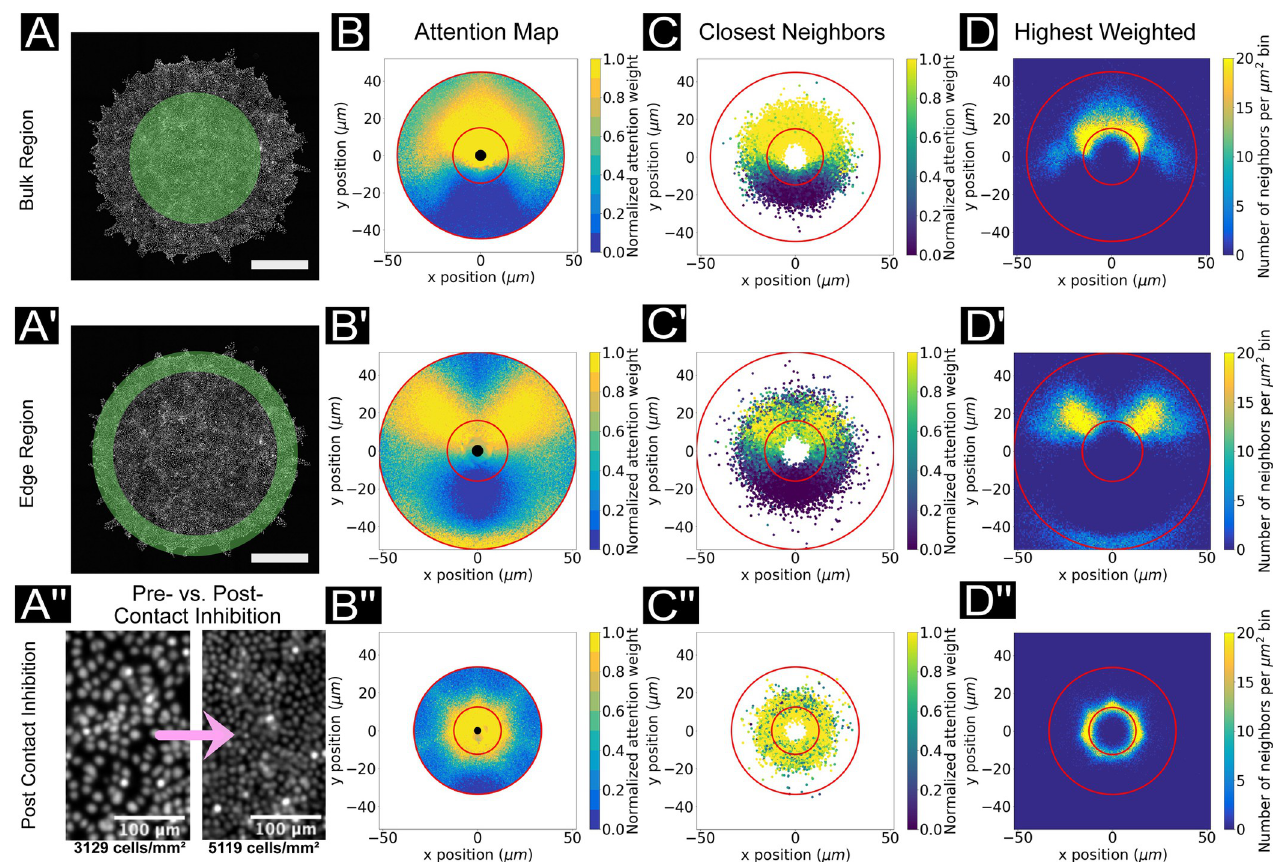
Fig 5. Biophysical modifications and attention. (A, A’) For these experiments, cell trajectory data is extracted from either the bulk region (A) or the edge region (A’) of the tissues. Scale bar represents 1 cm. (A”) Representative nuclei images of tissues before and after contact inhibition. Scale bars represent 200 μ m. (B � , C � , D � ) Attention map, closest neighbors scatter plot and histogram of highest weighted points, as before. (B, C, D) Network trained on MDCK cell trajectories taken from a circular ROI in the center of an expanding tissue, prior to contact inhibition. Plots are representative of the bulk region (see Methods ). (B’, C’, D’) Network trained on MDCK cell trajectories taken from an annulus along the outer region of a circular expanding tissue, prior to contact inhibition. Plots are representative of the edge region of the tissue (see Methods ). (B”, C”, D”) Network trained on MDCK cells in the bulk region, after contact inhibition. Plots are representative of a jammed tissue (see Methods